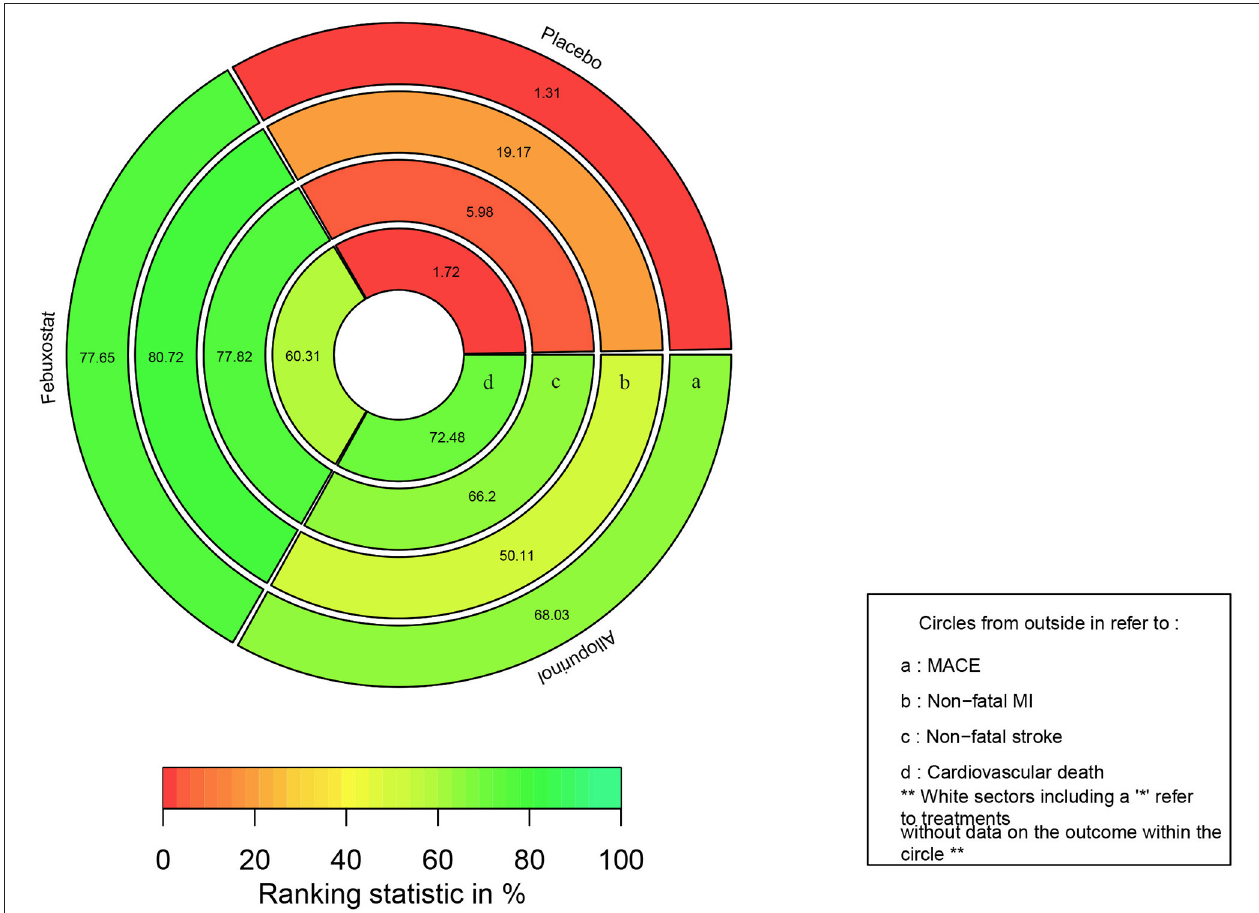
FIGURE 5 | Rank-heat plot based on SUCRA. Each sector is colored according to the SUCRA (Surface under the cumulative ranking) value of the corresponding treatment and outcome. The scale consists of the transformation of three colors: red (0%), yellow (50%), and green (100%), and each color is associated with a different evaluating indicator. MACE, major adverse cardiovascular events; MI, myocardial